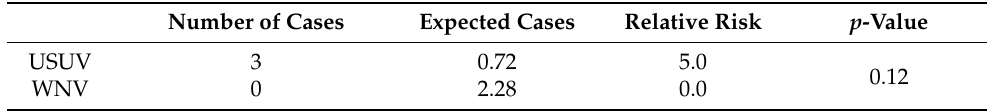
Table 3. Results of the most likely cluster in the purely spatial Bernoulli model implemented in SaTScan.